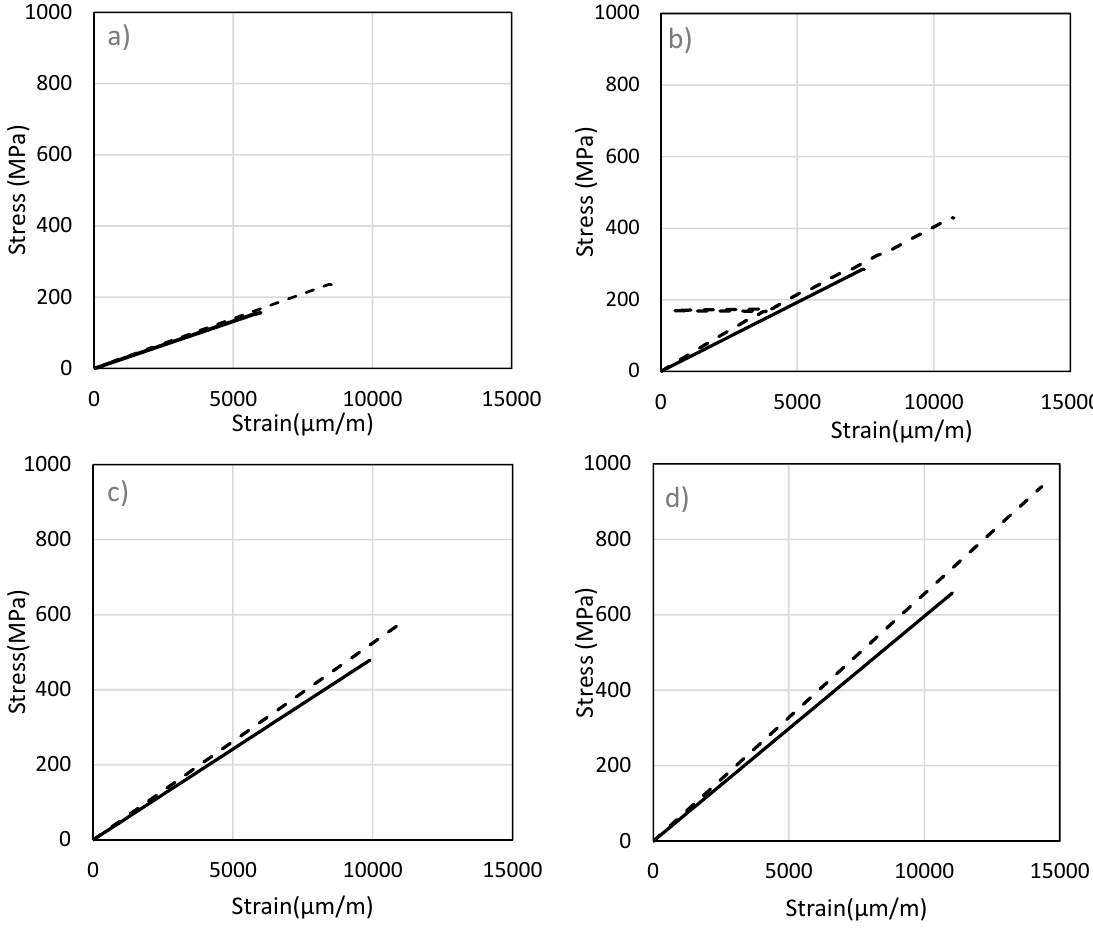
Figure 4. Stress–strain curve of fibers with different number of filaments: ( a ) 1 K, ( b ) 3 K, ( c ) 6 K and ( d ) 12 K; : bare fiber and : carbon fiber sensor.